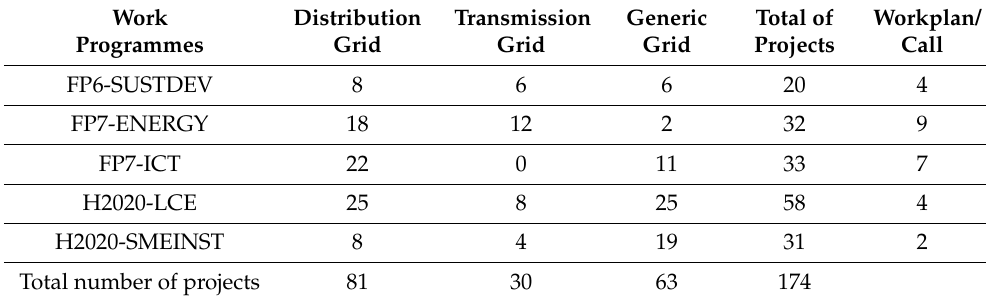
Table 3. Selected work programmes and categorised